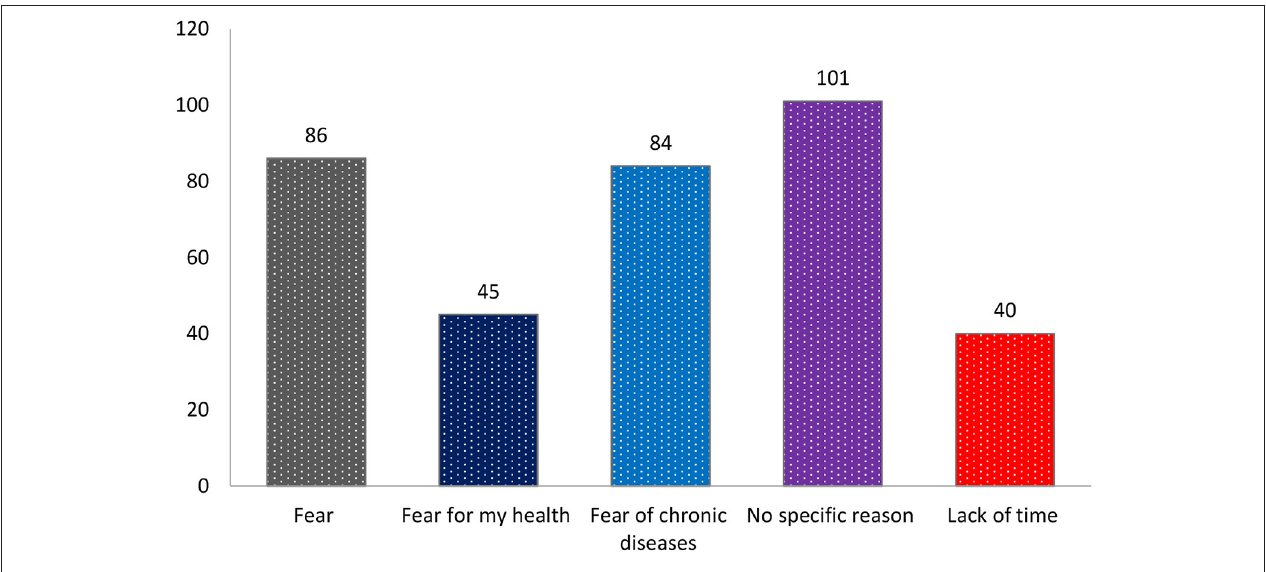
FIGURE 2 | Fears and misconceptions preventing donors from donating blood. (SPSS Inc., Chicago, IL, USA) was used for statistical analysis. A chi-square test was used to identify associations